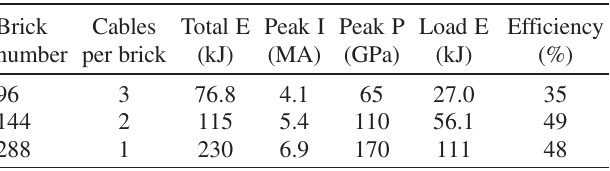
TABLE II. Comparison of load performance for 10-mm-wide panels with 96-, 144-, and 288-brick Thor. Cables are approx- imately impedance matched to the bricks as described in Sec.